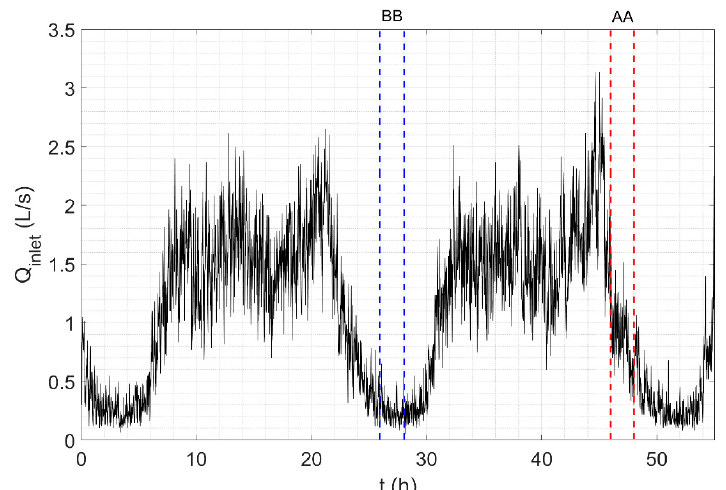
Figure 4. Flow rates observed at the inlet section of the district metered area of Gorino Ferrarese (Ferrara, Italy) from 15/01/2018 to early 17/01/2018. The periods AA and BB reproduced in the laboratory tests are also indicated.